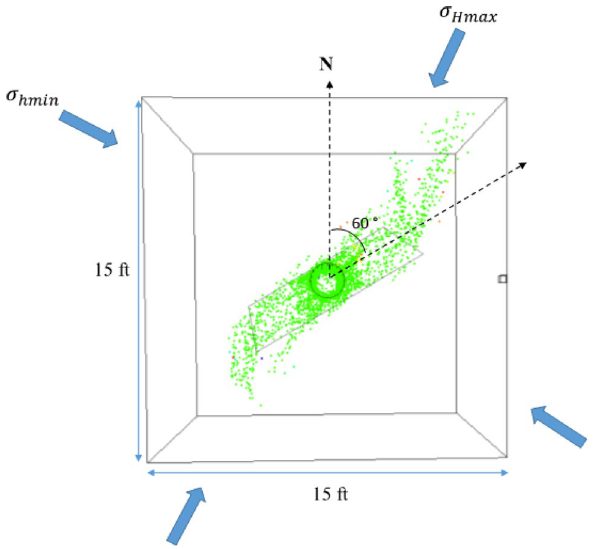
Fig. 16 Top view of fracture propagation (green dots) in the numeri- cal simulation with a single preexisting fracture (gray rectangular crossing the wellbore) with dip direction of 60°. Fracture propagation starts from the natural fracture, and propagation bends toward a plane normal to the minimum principal stress